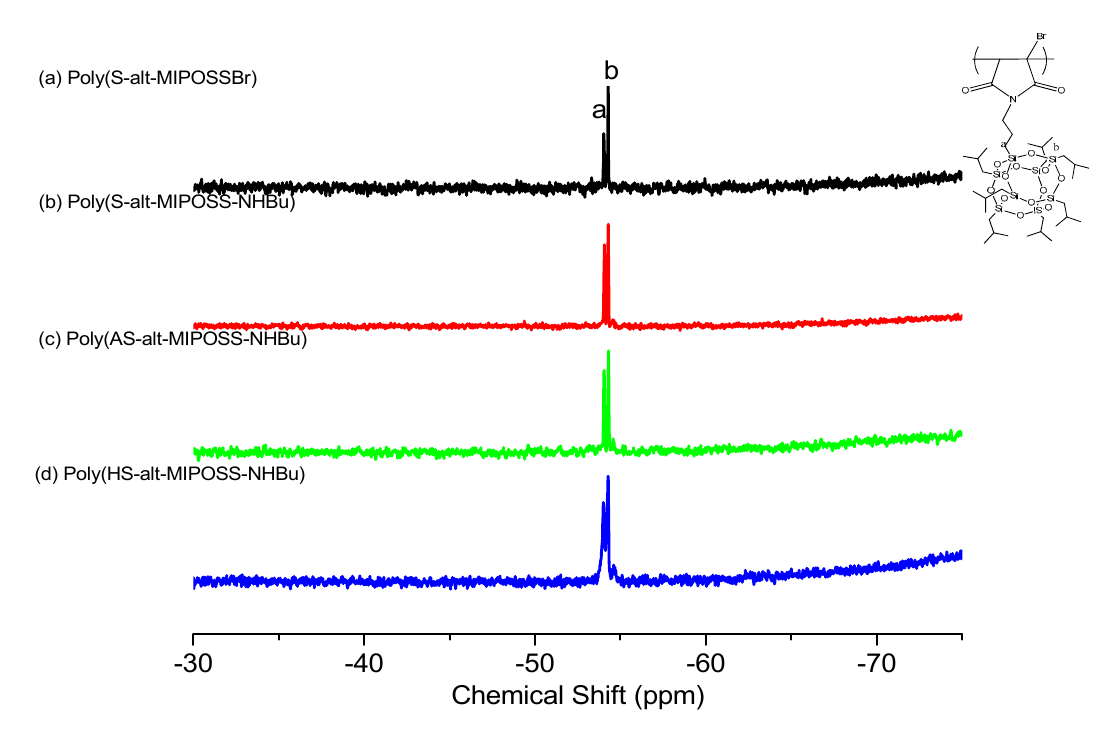
Figure 6. 29 Si-NMR spectra of: ( a ) poly(S- alt -MIPOSS-Br); ( b ) poly(S- alt -MIPOSS-NHBu); ( c ) poly(AS- alt -MIPOSS-NHBu); and ( d ) poly(HS- alt -MIPOSS-NHBu). Inset figure is corresponding to the chemical structure and peak assignment of 29 Si NMR of poly(MIPOSS-Br). Table 1. Molecular weights, glass transition temperatures, and quantum yields of the alternating copolymers. Sample M n a M w a PDI a S- alt -MIPOSS-Br